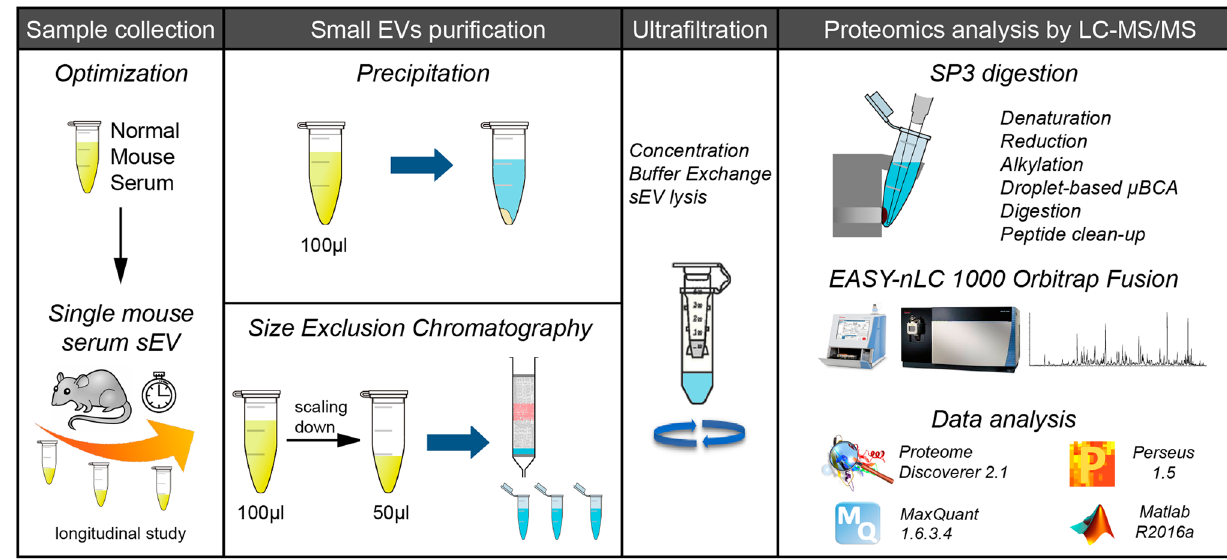
Figure 1. Experimental workflow. Comparison between two sEV isolation procedures: precipitation (PPT) and Size Exclusion Chromatography (SEC) using 100 µl of mouse serum. SEC was then scaled down on vesicles isolated from 50 µl of serum. As a proof of concept, the ultrasensitive microproteomics workflow was then applied to a longitudinal study of a glioblastoma multiforme mouse model. Purified sEV’s were concentrated and lysed on protein concentrator spin filters; then extracted, quantified and digested with a modified SP3 protocol. Peptides were analyzed by nLC-MS/MS, and the data analyzed with Proteome Discoverer 2.1 and MaxQuant software. Statistical analysis was performed using Perseus and